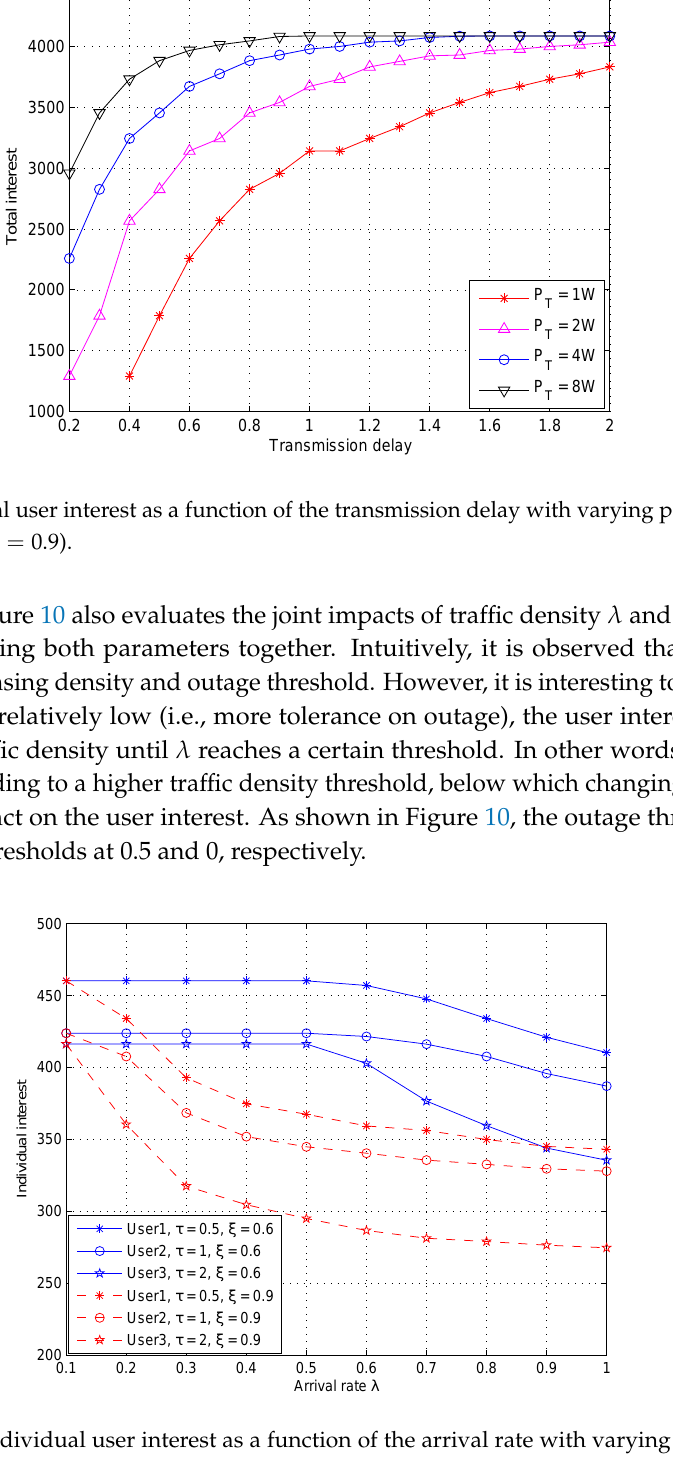
Figure 10. The individual user interest as a function of the arrival rate with varying user delay and outage requirements ( U = 3 and P T = 0.5 W